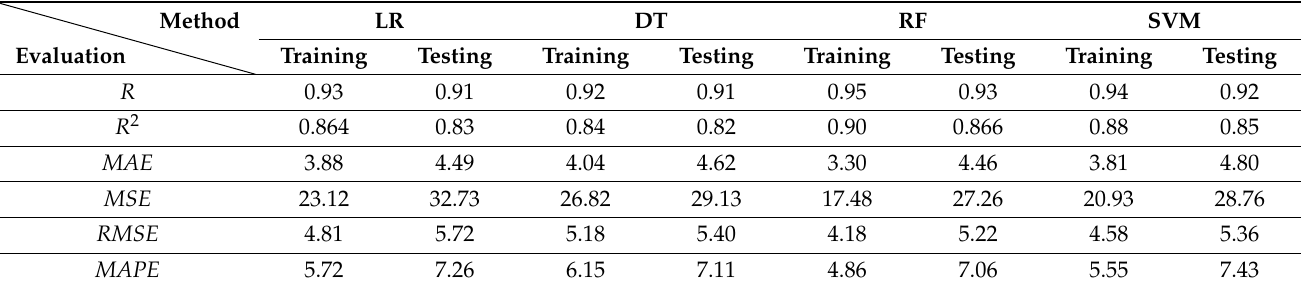
Table 3. Results of predictions with LR, DT, RF, and SVM models with all parameters.